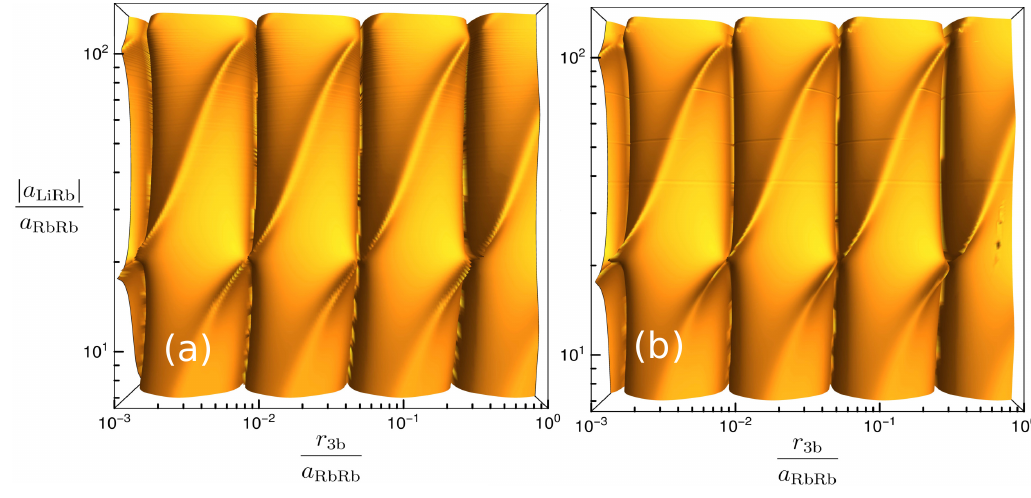
∣ a HL ∣ and r 3 b for the 6 Li- 87 Rb- 87 Rb system at low energy a HH a HH